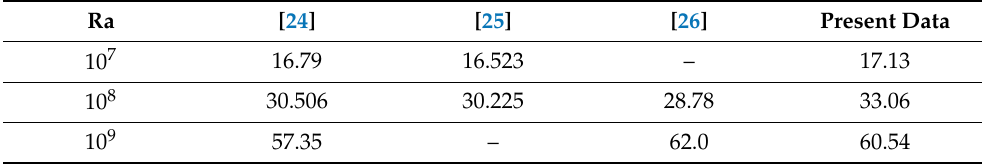
Table 2. Comparison of average Nusselt numbers ( Pr =